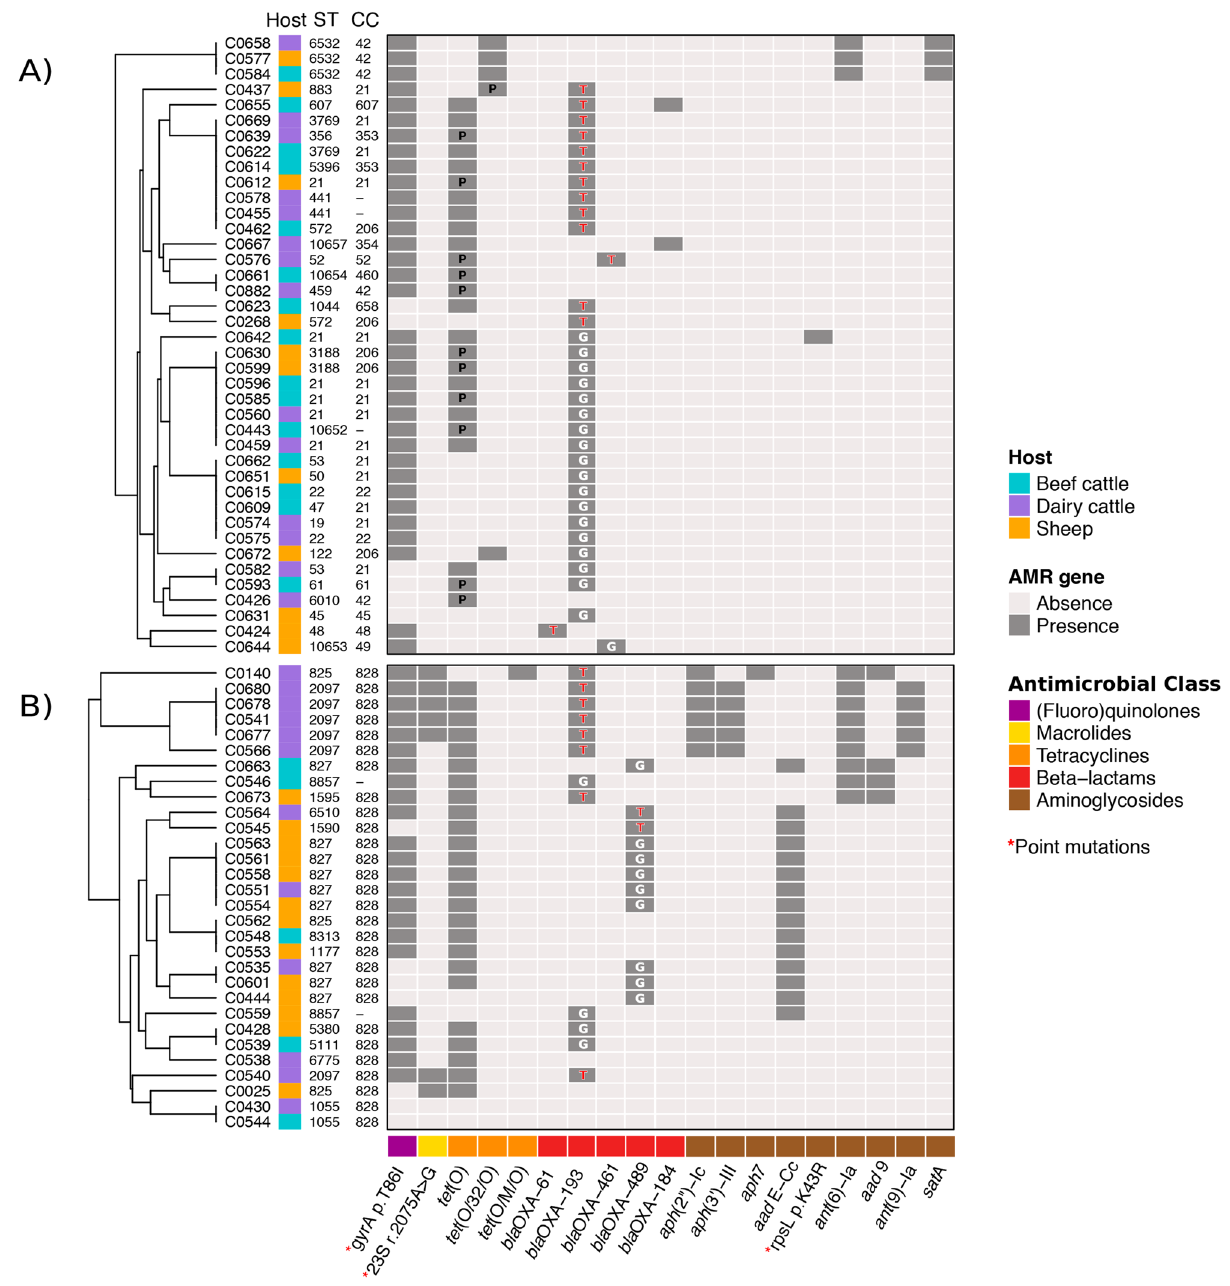
Figure 1. Heat map showing the distribution of antimicrobial resistance (AMR) genes detected by WGS in each isolate: ( A ) C. jejuni ; ( B ) C. coli . Within each Campylobacter species, samples were grouped based on their antimicrobial resistance pattern according to the result of the hierarchical clustering using the average linkage method (UPGMA) on the Euclidean distance matrix. Genetic determinants of resistance are grouped according to their corresponding antimicrobial classes, which are colour coded. Assignation of each isolate to MLST profiles is indicated (ST, sequence type; CC, clonal complex). In cells corresponding to bla OXA-61 -like genes, the nucleotide (G = guanine, T = thymine) at the promoter region (57 bp upstream of the start codon) is indicated (a G → T mutation is associated with high-level ampicillin resistance). Plasmid location of tet genes is indicated by the letter “P” in the corresponding